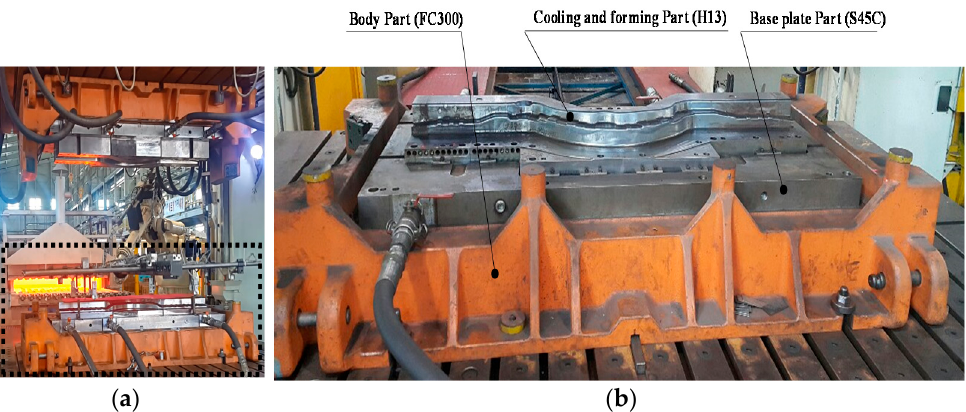
Figure 1. Example of a commercial hot-stamping die ( a ) production of hot-stamping parts ( b ) material applications of a hot-stamping die by function.